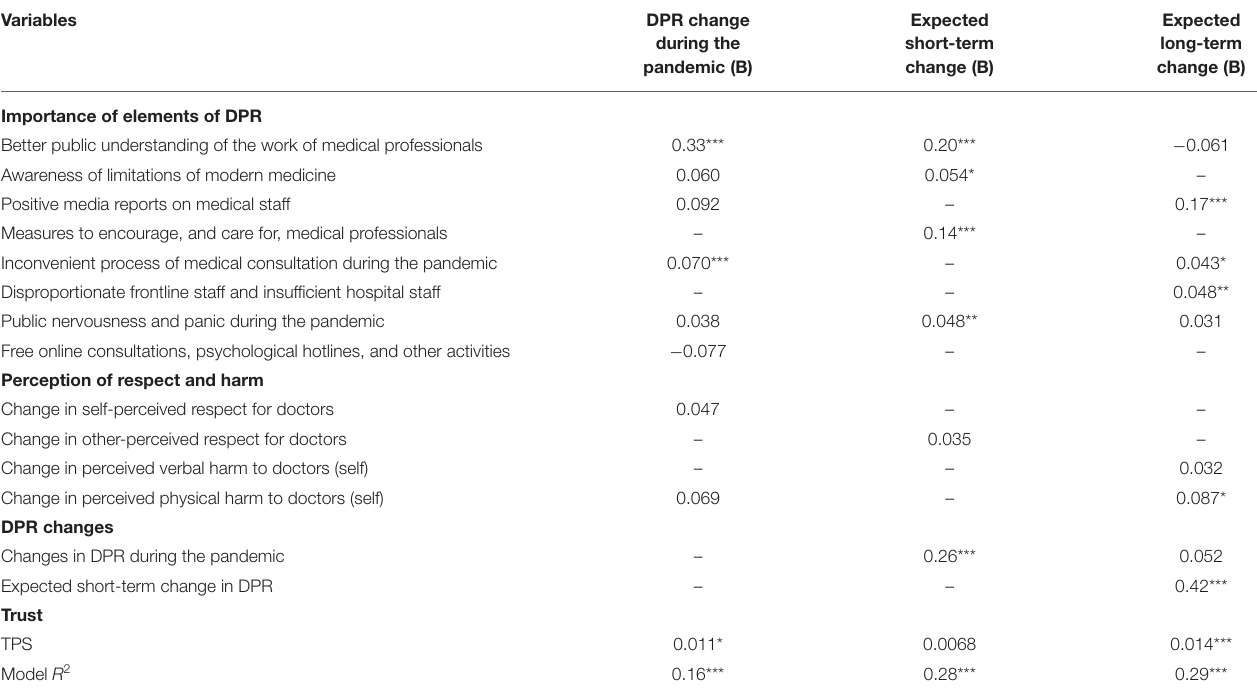
TABLE 3 | Regression weights of short-term and long-term doctor-patient relationship.